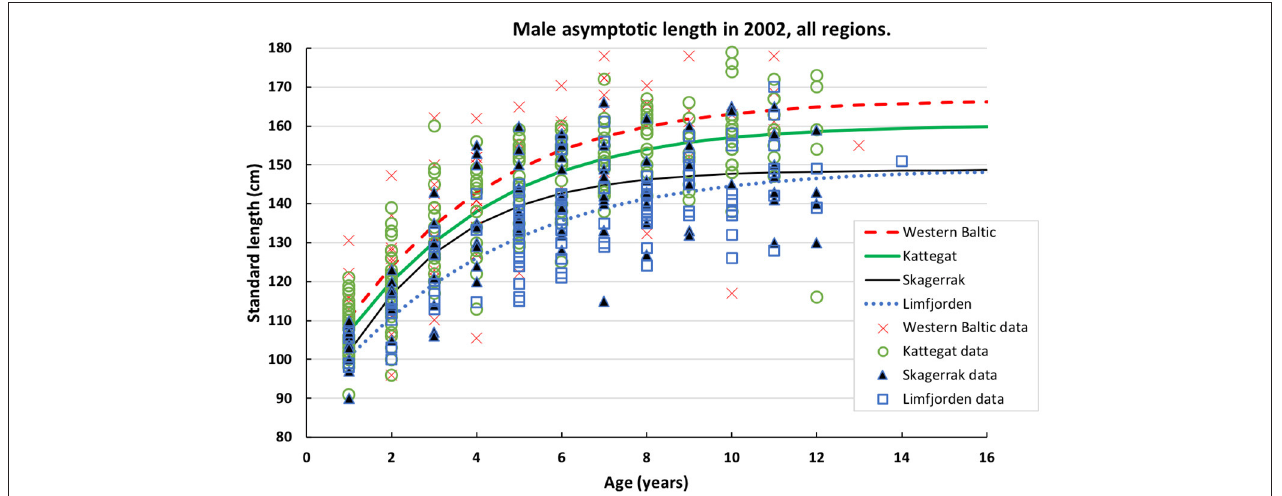
FIGURE 2 | Data on standard length of male harbor seals at age sampled in 2002 in four populations of harbor seals. Data are fitted by the Gompertz function ( Table 2 ).